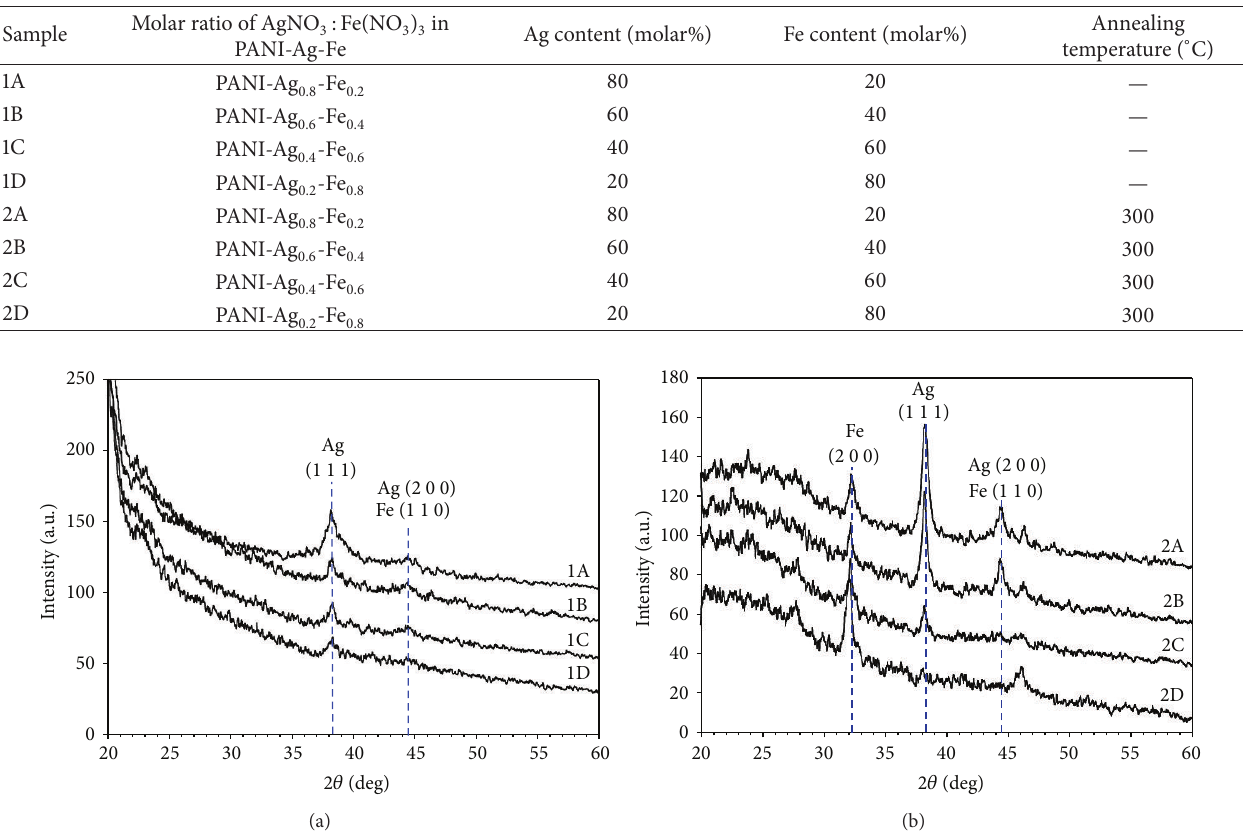
Table 1: Composition of metals in PANI-Ag-Fe nanocomposite.